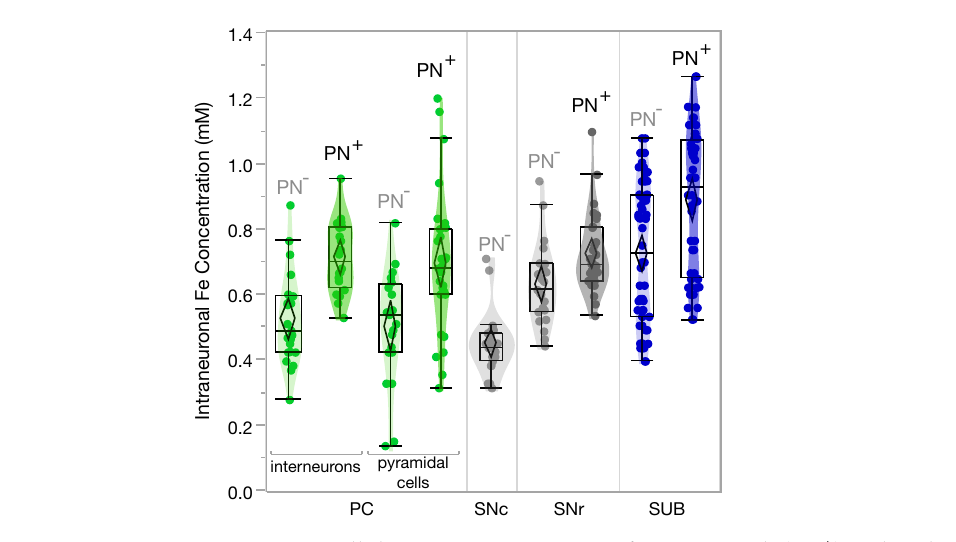
Figure 2. Intracellular iron concentrations of neurons with (PN + ) and without (PN – ) a PN in the parietal cortex (PC), subiculum (SUB), and substantia nigra pars reticulata (SNr)/compacta (SNc). PN + vs. PN – p < 0.01, SNc p < 0.02 (Student’s t -test).